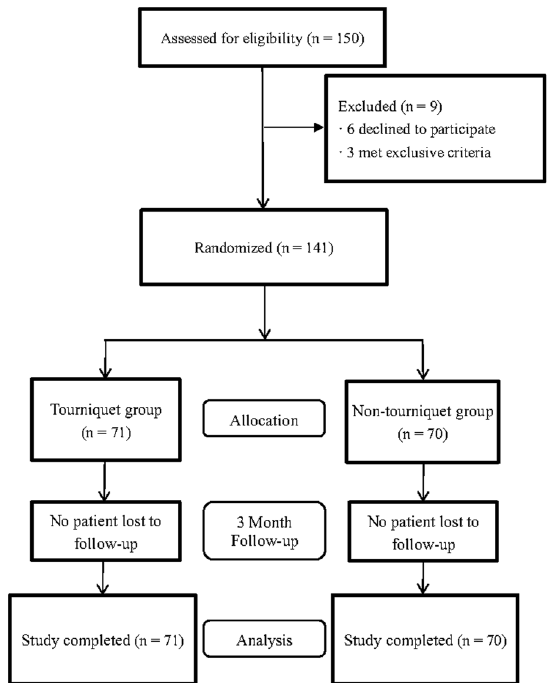
Fig. 1 Flowchart of patient